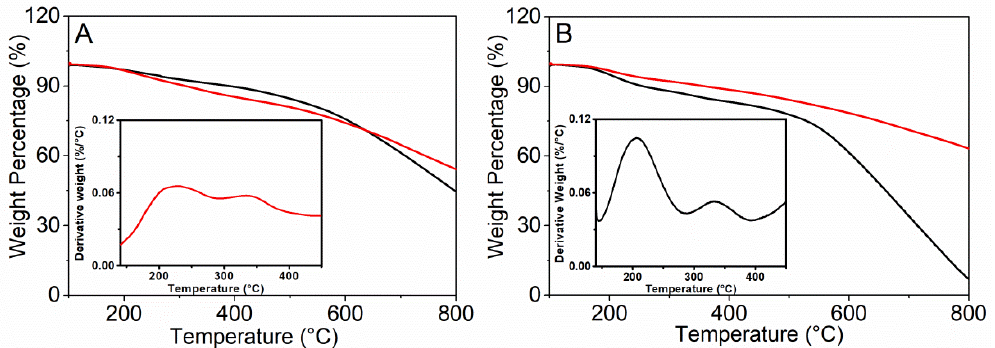
Figure 2. TGA profiles of MWCNT-Ox (dark line) and MWCNT-EPA (red line) ( A ). TGA profiles of MWCNT-EDABoc (dark line) and MWCNT-EDA (red line) ( B ). In the insets DTG curve of MWCNT-EPA (A) and MWCNT-EDABoc (B). TGA analyses were carried out under N 2 atmosphere.